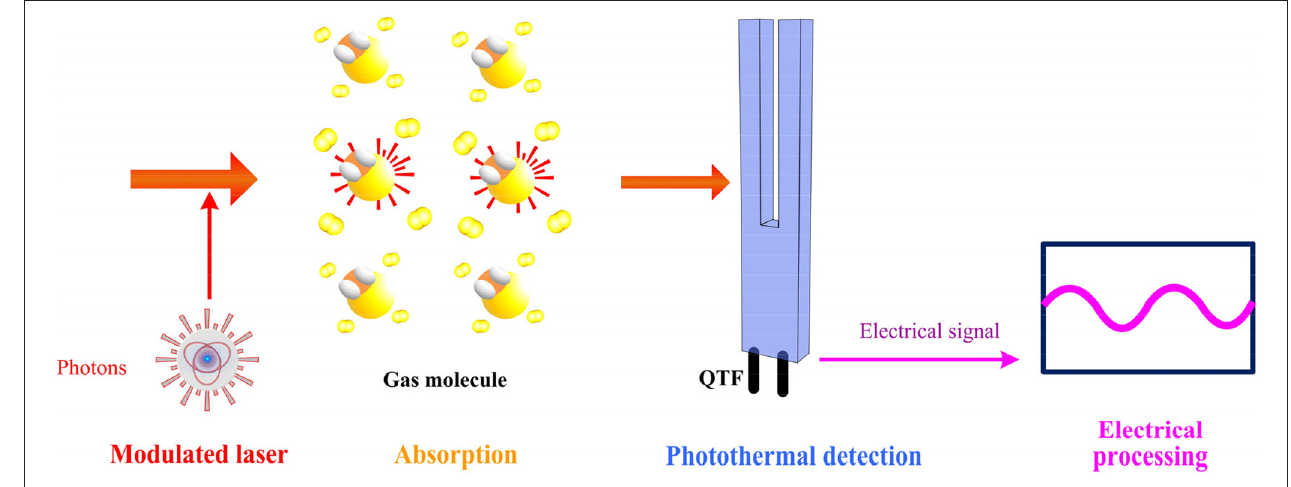
FIGURE 8 | The principle of quartz-enhanced photothermal spectroscopy (QEPTS).